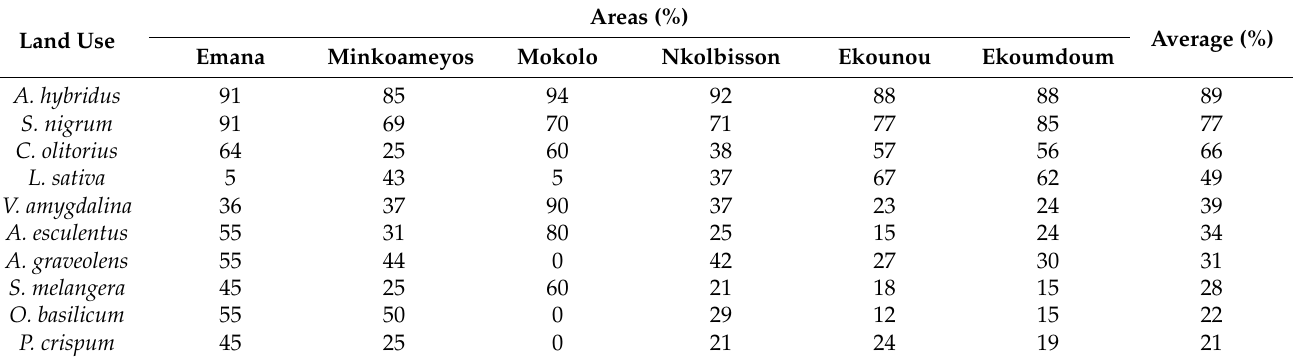
Table 3. Percentages of land use for vegetable crops grown in the six lowland study sites in Yaound é . Areas Land Use